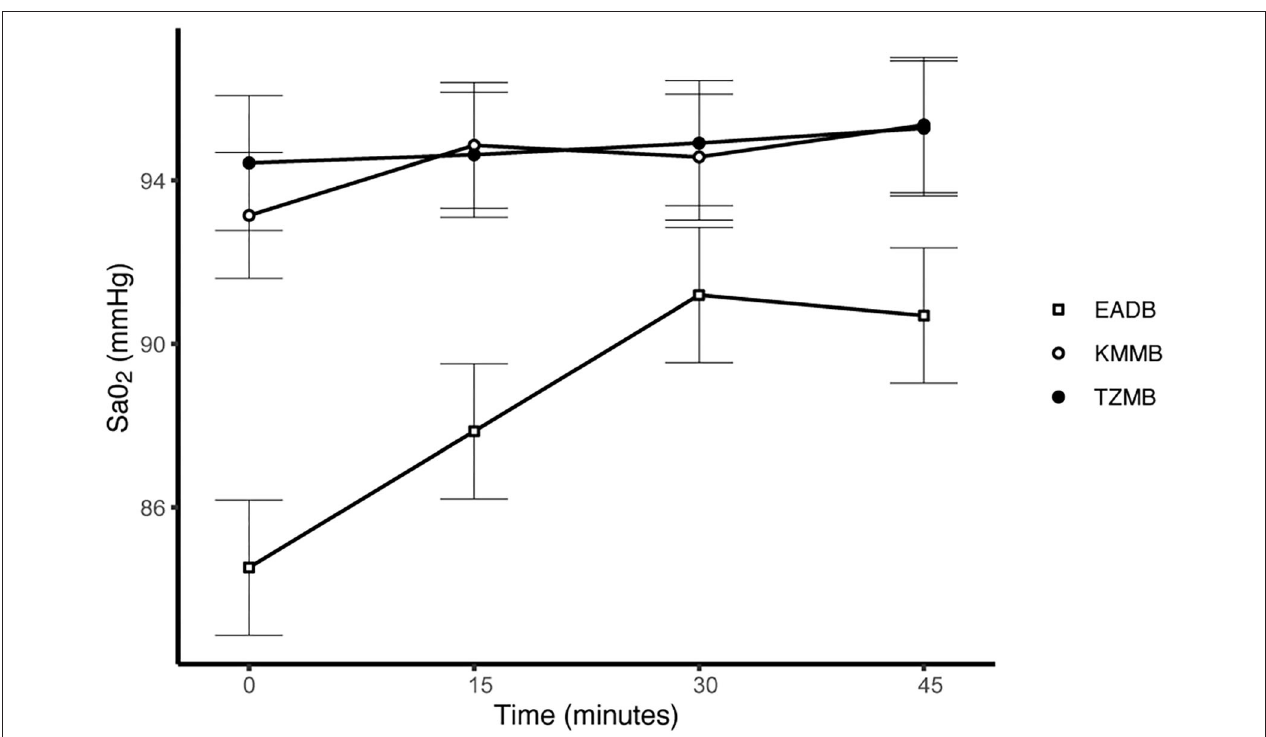
FIGURE 5 | Illustration of oxygen saturation (SaO 2 ) over time. Values of each timepoint are the means for treatment group 1 (KMMB), treatment group 2 (TZMB) and the control group (EADB) ± standard error (error